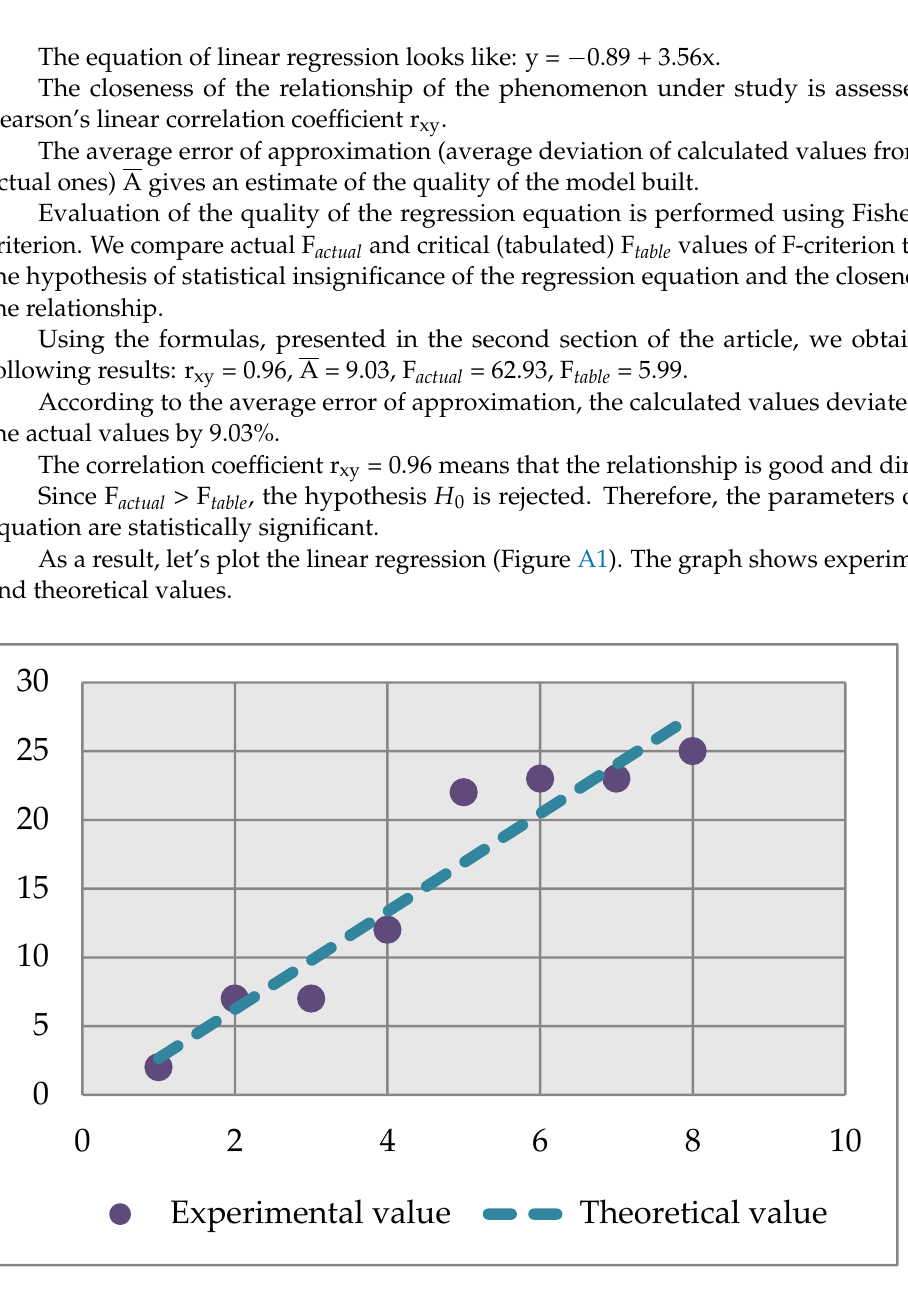
Figure A1. Linear regression.